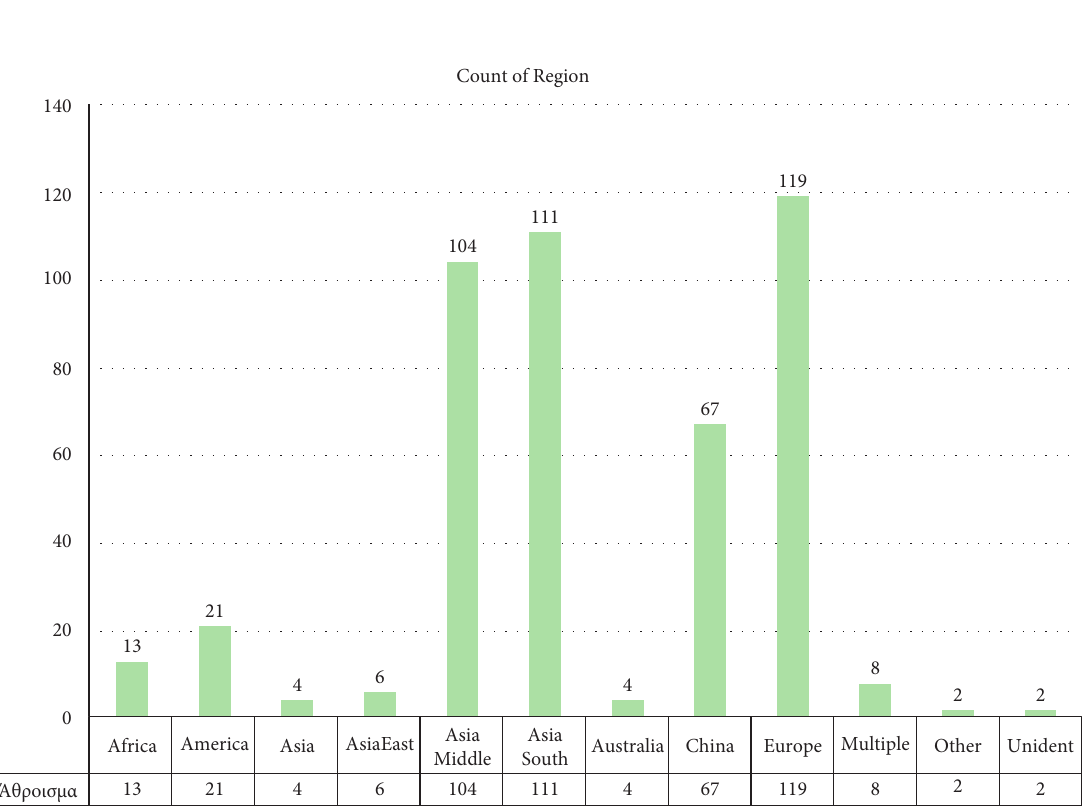
Figure 3: Count of year.